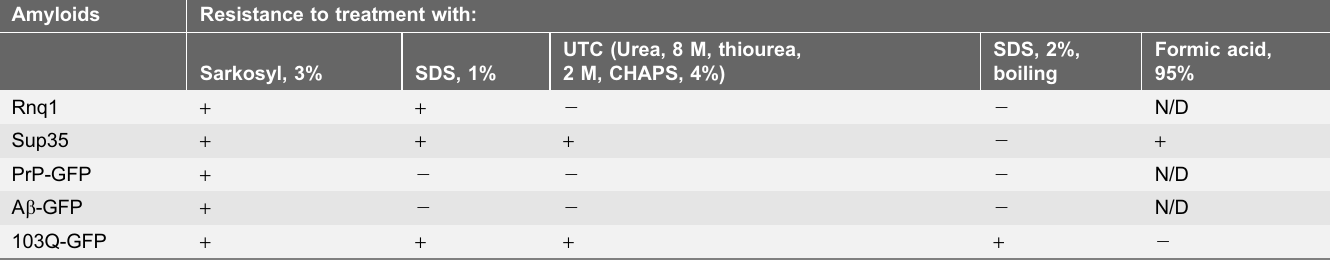
Table 6. Resistance of amyloids to solubilizing